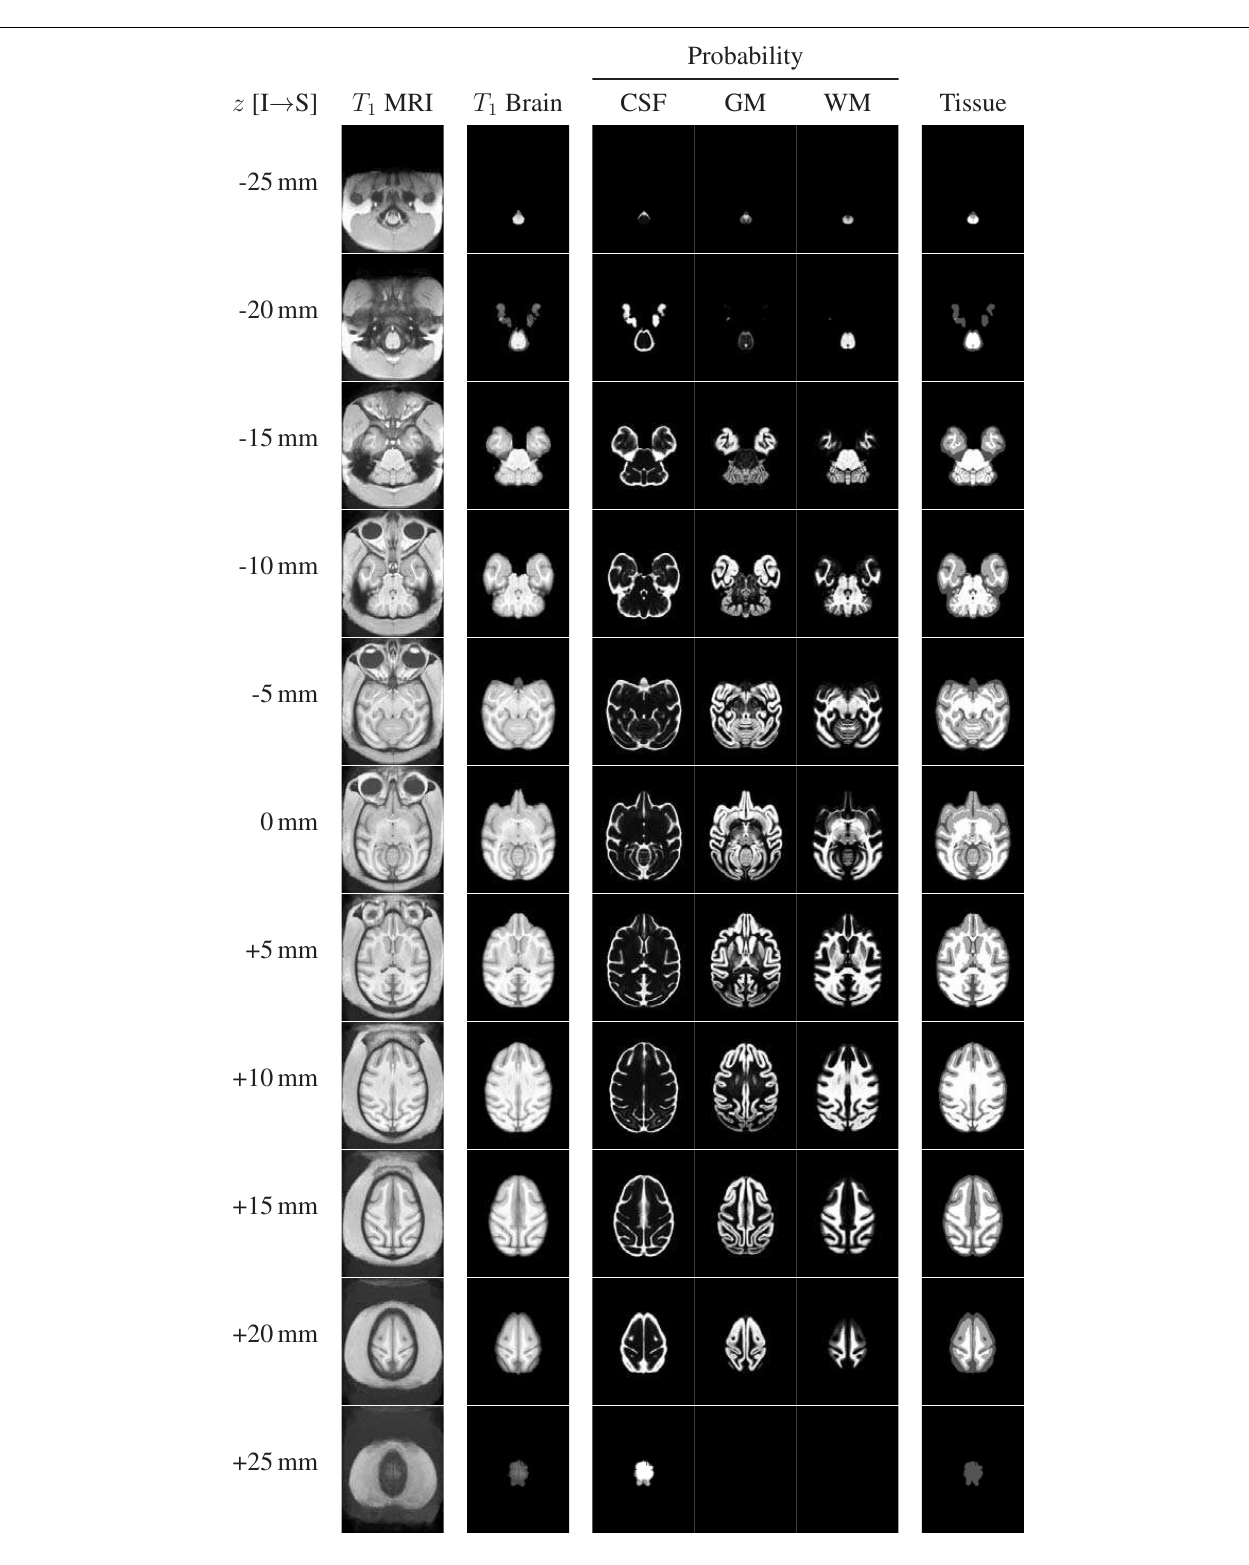
FIGURE 6 | Representative axial slices from the INIA19 atlas images (every tenth slice is shown). The slice location ( z coordinate in NIFTI RAS coordinate space) is provided in the leftmost column.The AC and PC landmarks are both located in the z = 0mm